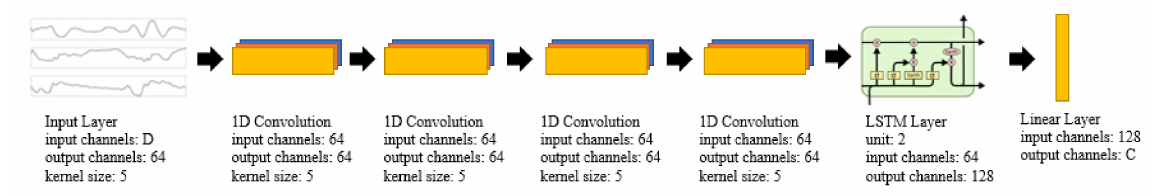
Figure 2. Model architecture for DeepConvLSTM (D: input data channel and C: number of class